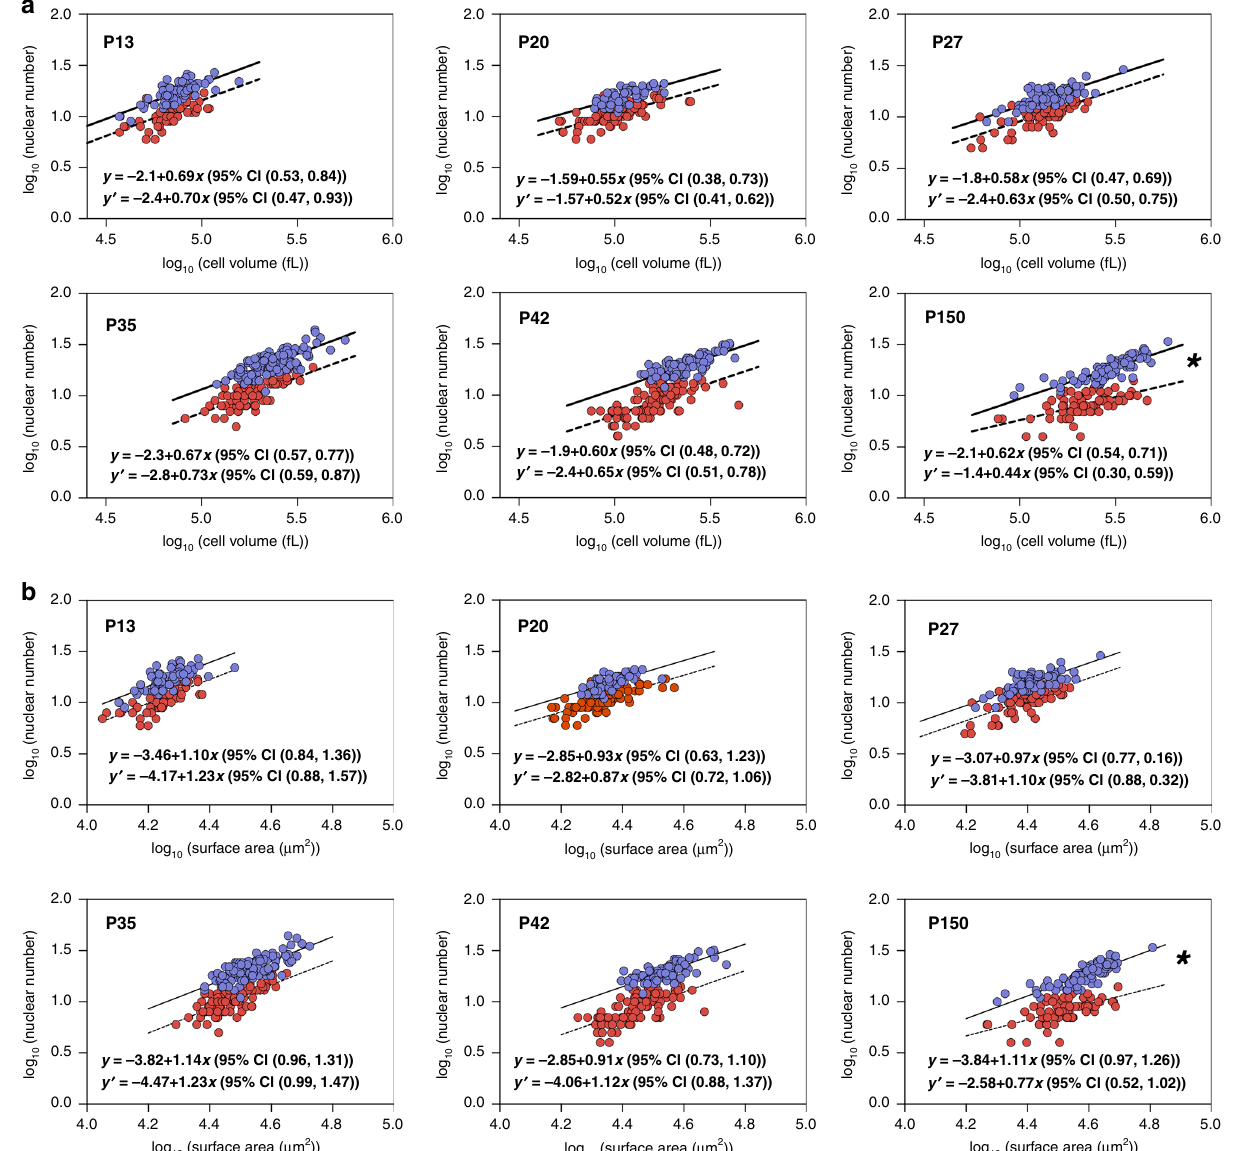
Fig. 5 Scaling behavior is retained during post-natal growth, also after inhibiting myonuclear accretion genetically. a Nuclear number versus cell volume in log – log space plotted from P13 to P150 for normal EDL cells (blue) and Δ 2w cells (red). Solid lines (control) and dashed lines ( Δ 2 w ) were fi tted after an OLS regression. Between group comparisons of the scaling exponent gave a p -value for each age as: P13 ( p = 0.9027), P20 ( p = 0.7705), P27 ( p = 0.6204), P35 ( p = 0.4528), P42 ( p = 0.6731), and P150 ( p = 0.0295, * statistically different at p < 0.05). The log – log model after fi tting for normal cells is highlighted by y , while y ′ represent the equation for Δ 2 w cells. b Nuclear number versus cell volume in log – log space plotted from P13 to P150 for normal EDL cells (blue) and Δ 2 w cells (red). Solid lines (control) and dashed lines ( Δ 2 w ) were fi tted after an OLS regression. Comparisons of the scaling exponent between the two groups gave a p -value for each age as: P13 ( p = 0.5471), P20 ( p = 0.8265), P27 ( p = 0.3758), P35 ( p = 0.5246), P42 ( p = 0.2006) and P150 ( p = 0.0170, *statistically different at p < 0.05). The log-log model after fi tting for normal cells is highlighted by y , while y ′ represent the equation for Δ 2 w cells. In a and b , the number of control cells for each age were: P13 = 74 cells, P20 = 50 cells, P27 = 80 cells, P35 = 135 cells, P42 = 89 cells, and P150 = 92 cells. The number of myomaker Δ 2 w cells were; P13 = 59 cells, P20 = 94 cells, P27 = 92 cells, P35 = 88 cells, P42 = 107 cells and P150 = 72 cells. All p -values were extracted from the extra sum-of-squares F -test. Source data are provided as a Source Data fi